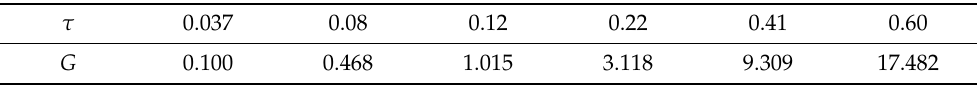
Table 1. Porous coefficient 𝐺 and the corresponding opening rate τ of the porous surface for ε = 0.05, based on Equation (11).